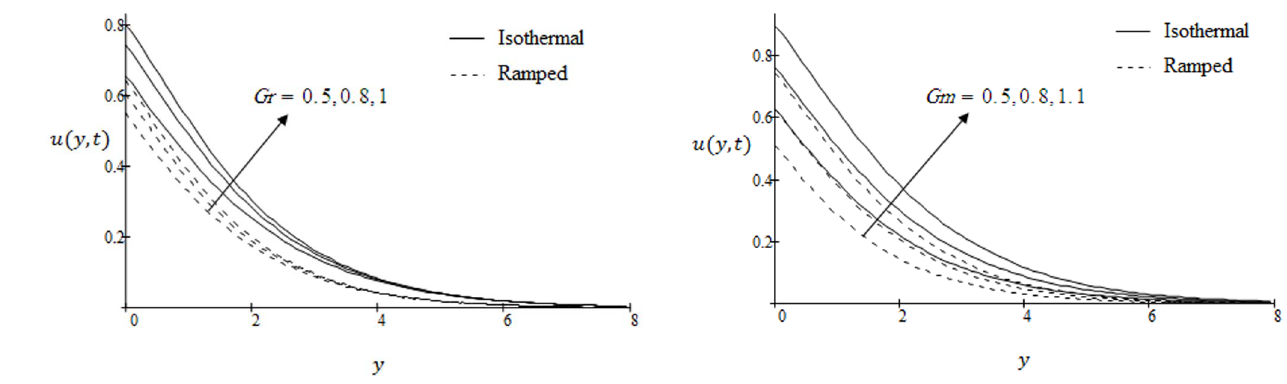
Figure 2. Velocity profiles for different values of Gr when the plate applies a constant shear stress f ~{ 0 : 25 .